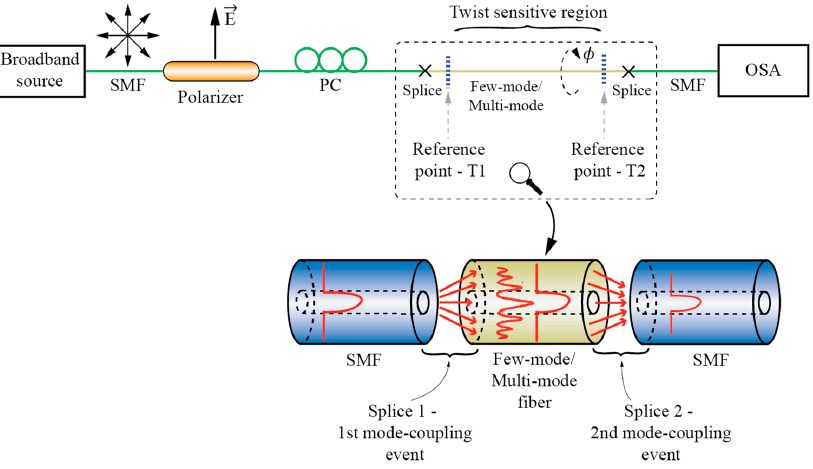
Figure 12. Fiber Mach-Zehnder interferometer for twist/rotation sensing.